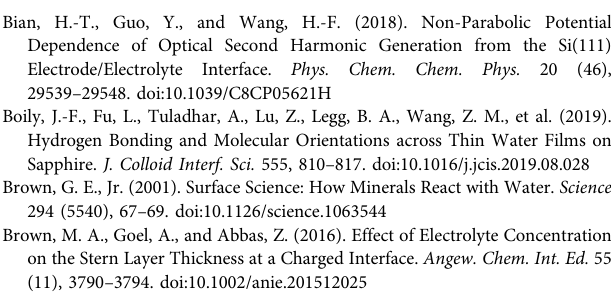
(highlighted in green) and downward (highlighted in black) alignments of water OH groups as shown in Figure 2D . The former con fl icted with the preferred downward fi eld induced